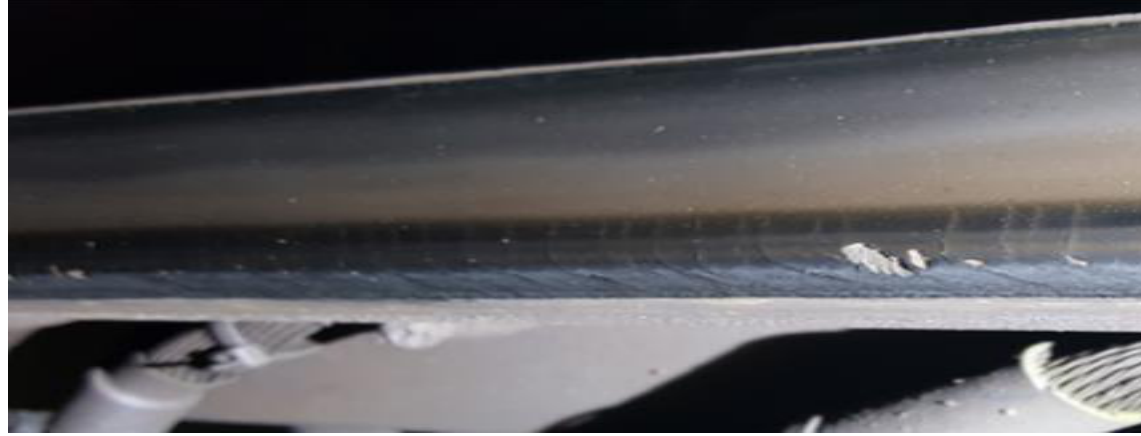
Figure 5. Head check.